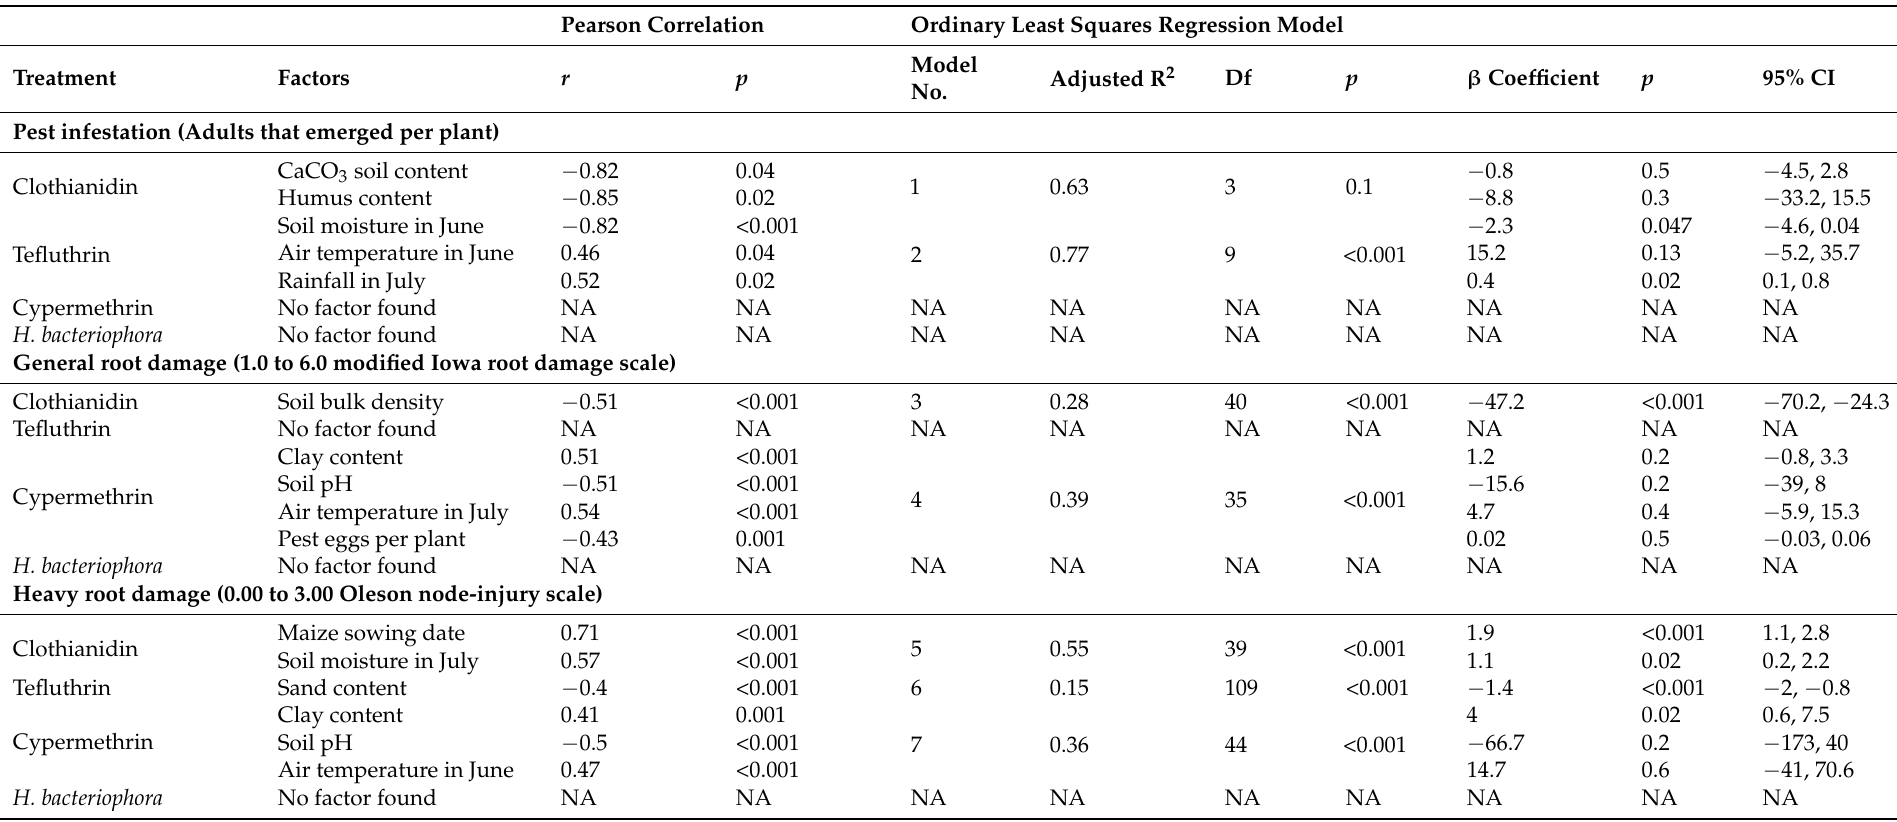
Table 2. Correlations and regressions between abiotic or biotic factors and the efficacy of soil insecticides and entomopathogenic nematodes in reducing Diabrotcia v. virgifera larvae and protecting against root damage in maize; only factors that had an influence are presented; n = 20 sites or fields in southern